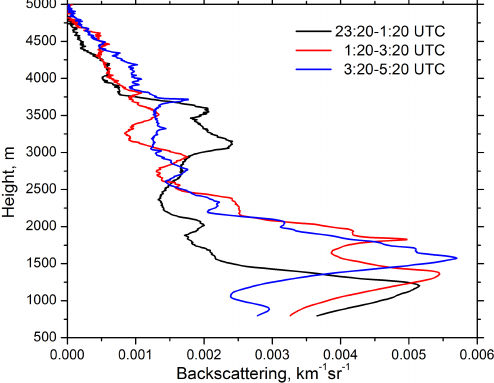
Figure 5. Vertical profiles of backscattering coefficients at 355nm on 26 August averaged over time intervals: 14:00–16:00, 16:30– 18:30 and 20:30–22:30UTC.